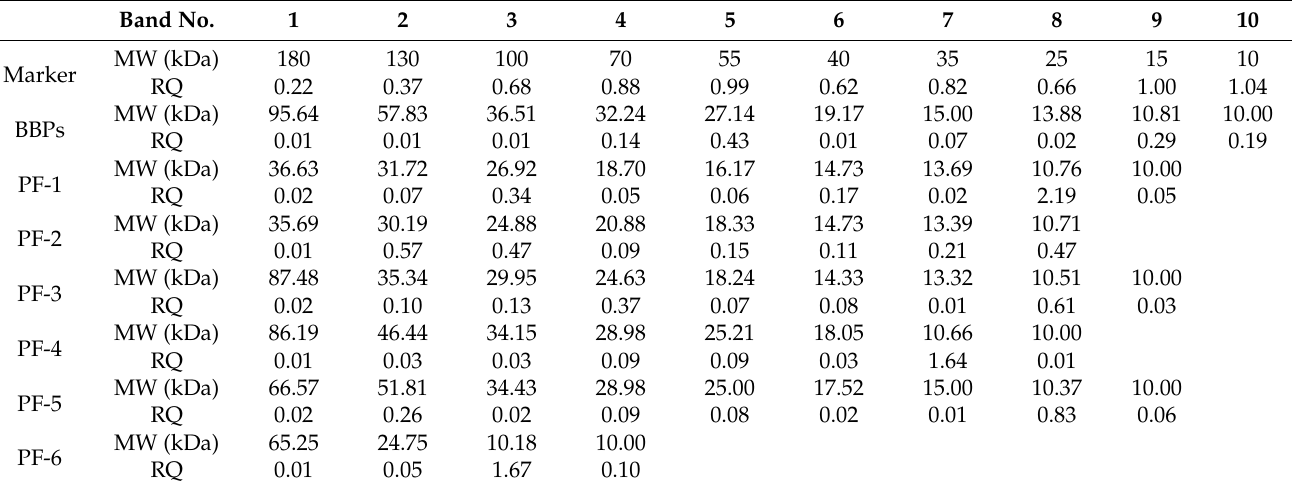
Table 1. The molecular weight and relative quantification of Markers, BBPs, PF-1, PF-2, PF-3, PF-4, PF-5 and PF-6.